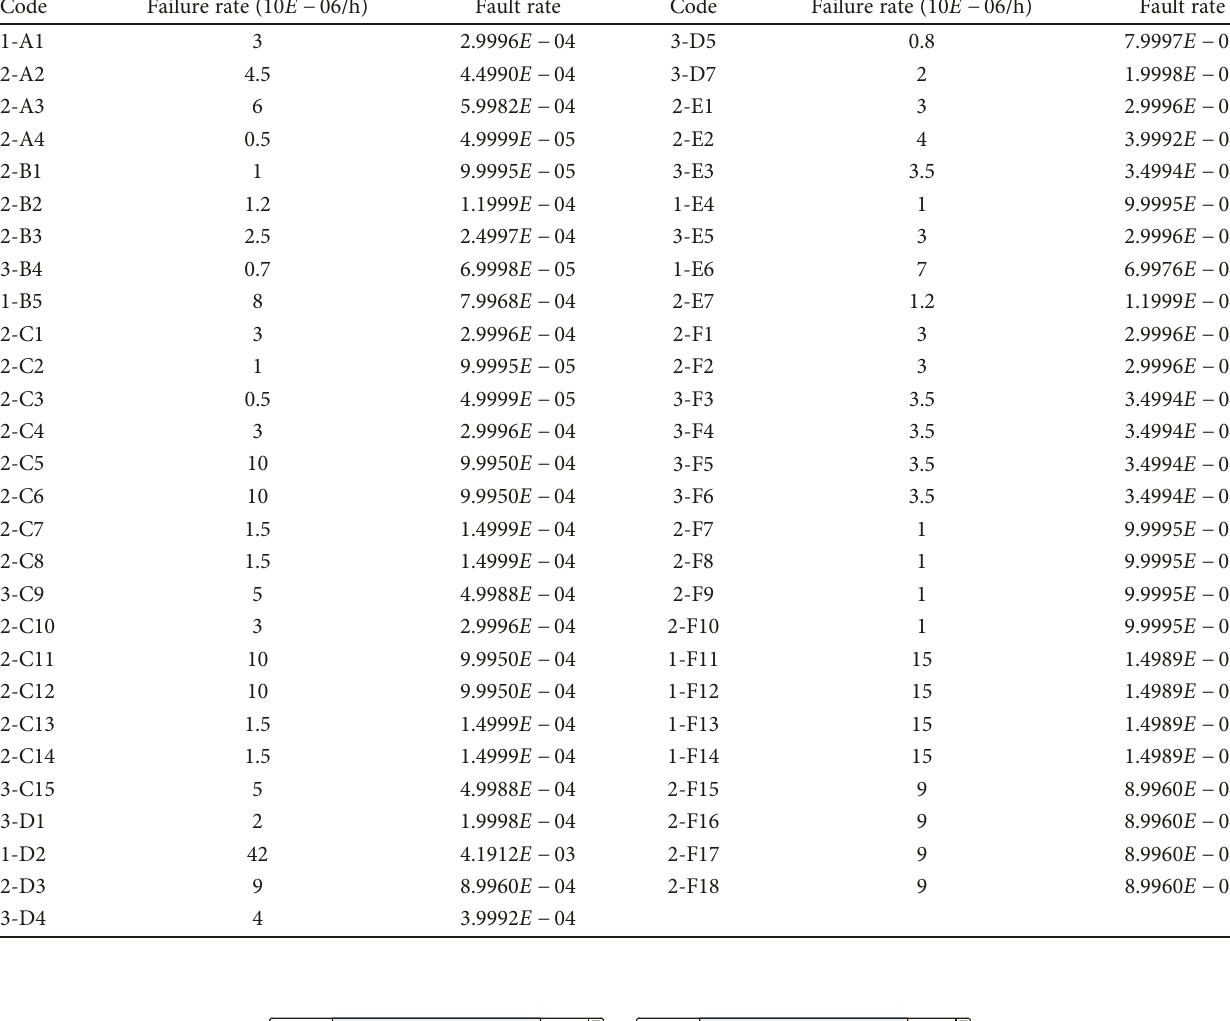
Table 4: Initial data for the basic units in the model from real-time train safety monitoring system.